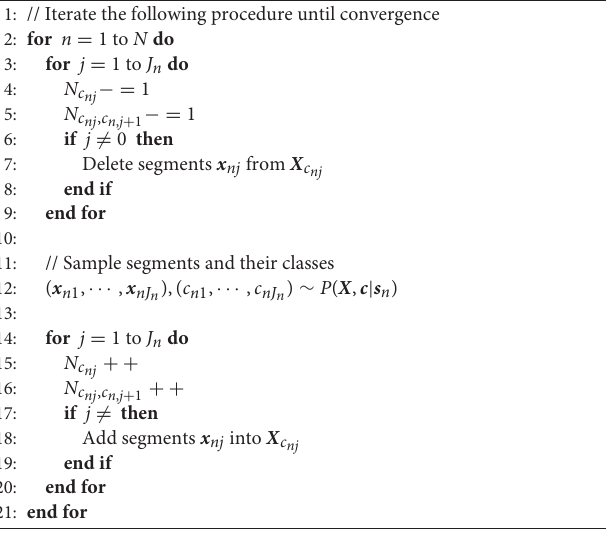
Algorithm 1 Blocked Gibbs Sampler